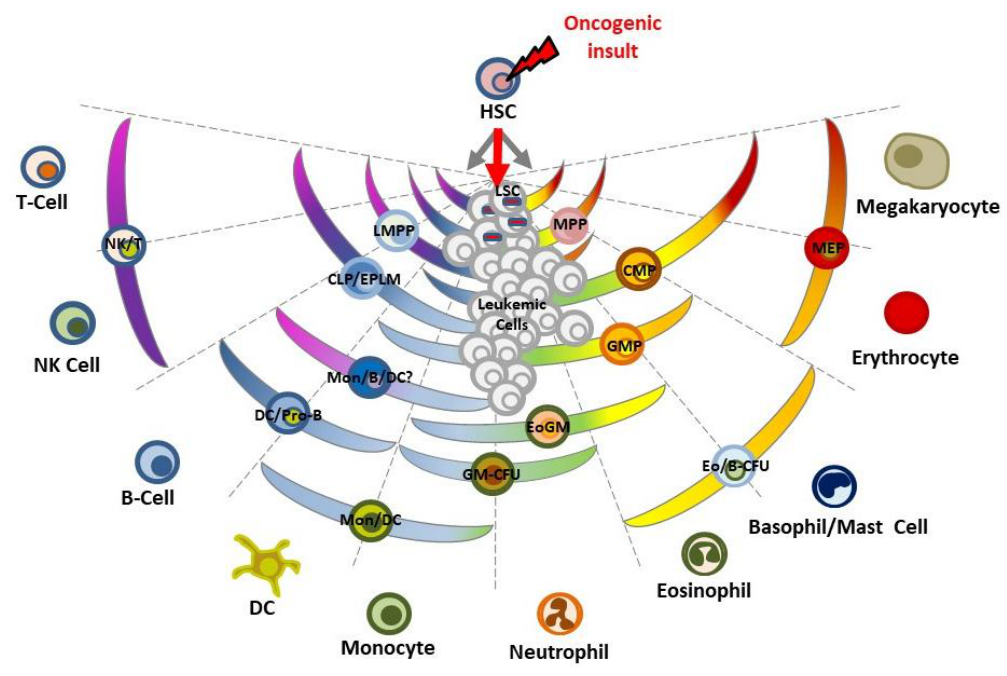
Figure 4. Schematic representation of the emergence of LSCs in the making of a leukemia. A mutation occurs in HSCs leading to the emergence of aberrant pre-leukemic HSCs. These aberrant pre-leukemic HSCs self-renew and expand within the HSC compartment. Pre-leukemic HSCs give rise to a high number of lineage-committed progenitors harboring this identical mutation. This leads to an increased chance of acquiring the additional oncogenic/environmental events, which finally transform the aberrant progenitor cells from pre-leukemic HSCs into the leukemic stem cells (LSCs). Loss of differentiation potentials is essential for the emergence of LSCs. LSCs are reprogrammed by an oncogenic insult to an invariant cell lineage. Hematopoietic stem cell (HSC), Multipotent progenitor cell (MPP), Lymphoid-primed MPP compartment (LMPP), Common myeloid progenitor (CMP), Common lymphoid progenitor (CLP), Early progenitor with lymphoid and myeloid potential (EPLM), Granulocyte-macrophage progenitor (GMP), Monocytes (Mon), Eosinophil-granulocyte-macrophage (EoGM), Granulocyte-macrophage progenitor-colony forming unit (GM-CFU), Dendritic cell (DC), Megakaryocyte-erythroid progenitor (MEP), Natural Killer cell (NK), Eosinophil/Basophil-colony forming unit (Eo/B-CFU).